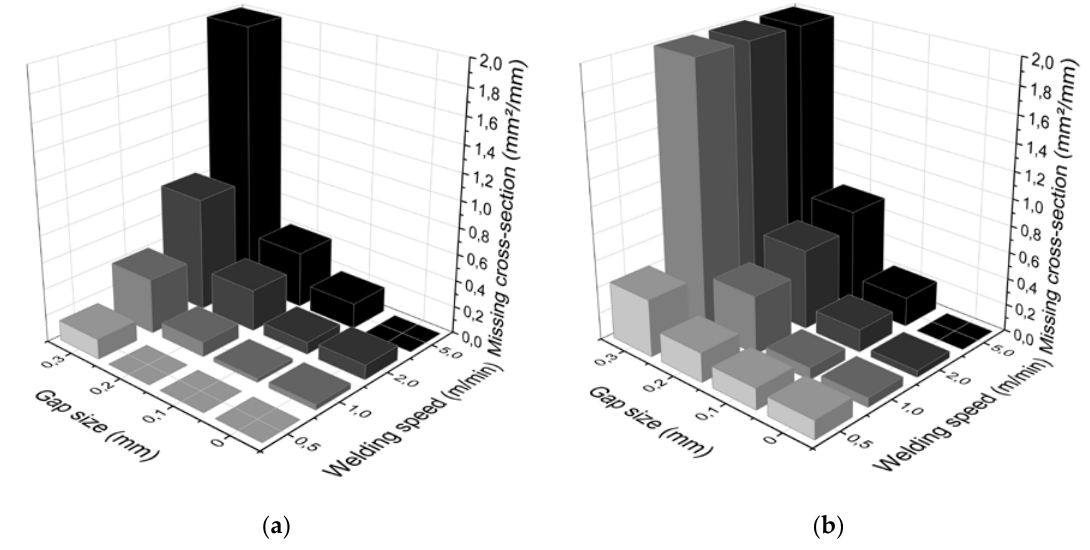
Figure 4. Missing cross-section per mm weld seam length depending on welding speed and gap size for welding at atmospheric pressure ( a ) and 10 hPa ( b ).